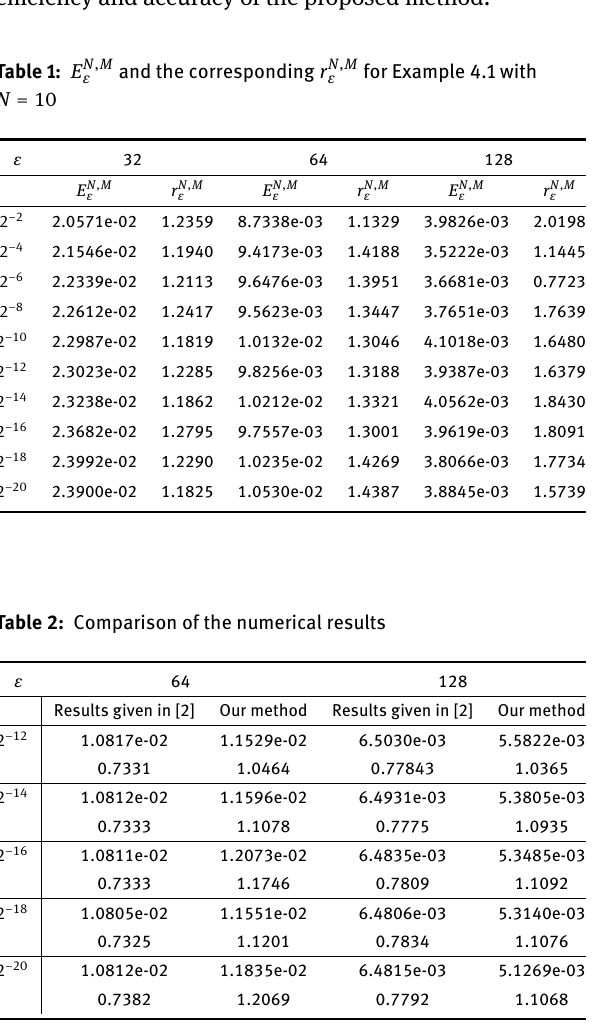
Table 1: E N , M ε and the corresponding r N , M ε for Example 4.1 with